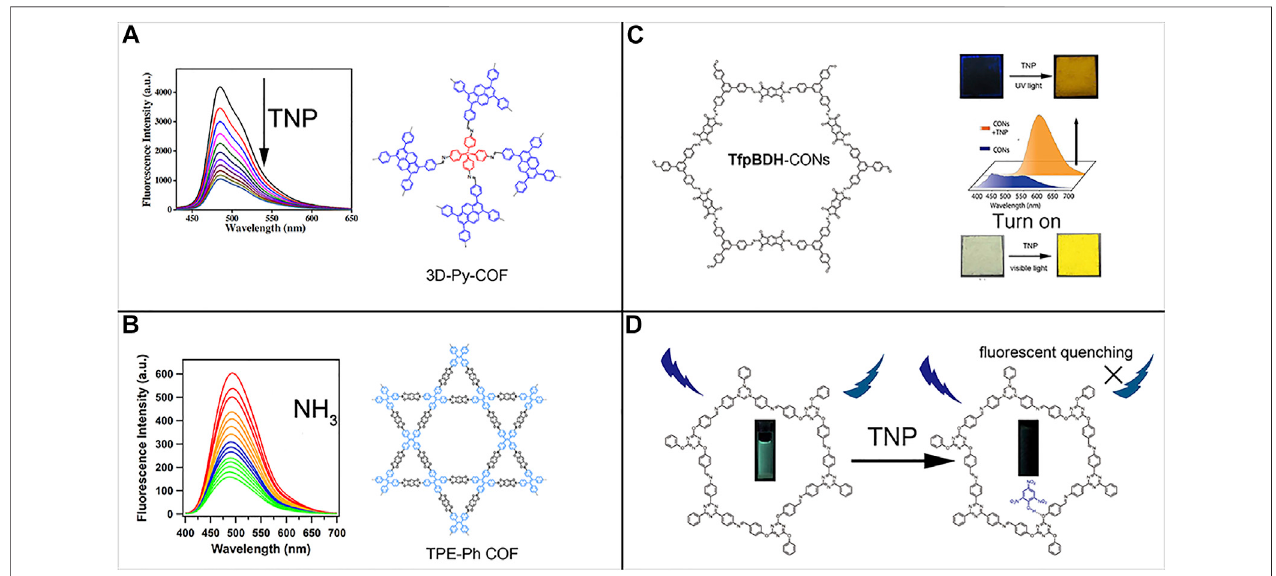
FIGURE2|(A) Three-dimensionalnon-conjugation-induced fl uorescent3D-Py-COF(Linetal.,2016). (B) AIEgen-monomer-induced fl uorescenttwo-dimensional TPE-Ph-COF(Dalapatietal.,2016). (C) TfpBDH-CONssolid-state sensingtoTNPunderUV(365 nm)andvisiblelightinaturn-onmode(Dasetal.,2015). (D) DTZ-COF turn-off fl uorescence response to TNP (Li et al., 2019). Adapted with the permission from the American Chemical Society and the Royal Society of Chemistry.